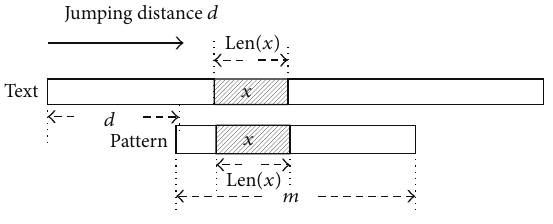
Figure 5: 𝑑 -jumping distance from right ( 𝑑 ≤ 𝑚 ).